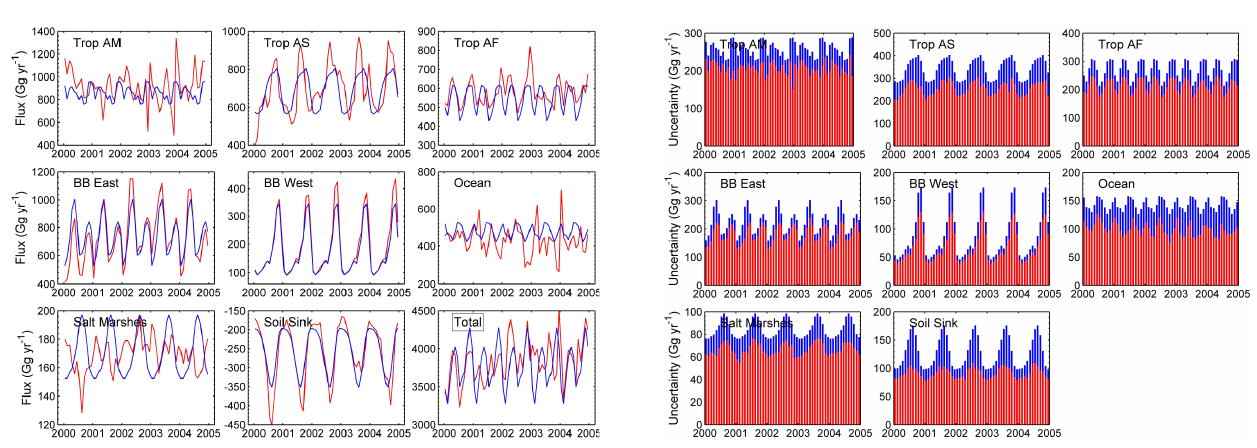
Fig. 7. The corresponding uncertainties (1 σ error bars) of the inver- sion results in Fig. 6, with the optimized error bars (red) superim- posed upon the reference error bars